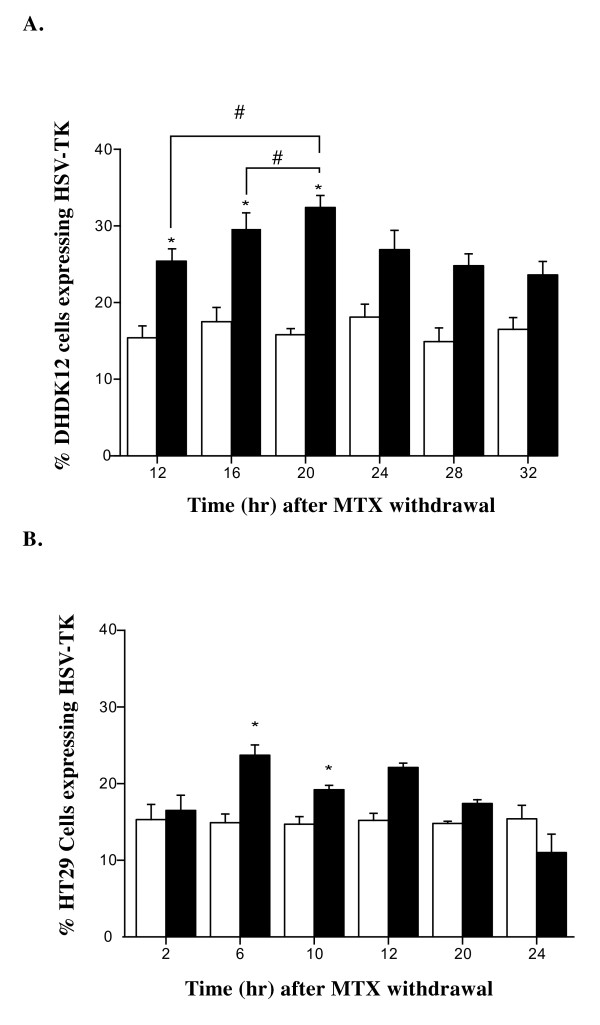
Infection efficiency of the HSV-tk retroviral vector. DHDK12 cells (A) and HT29 cells (B) were treated for 24 hr with (filled square) or without (open square) MTX. Cells were transduced with TG 9344 at the indicated times after MTX washout. The HSV-TK expression level was determined 48 hr after transduction by flow cytometry using a mouse monoclonal 4C8 antibody against HSV-TK protein. Data are expressed as the mean ± SE from at least three separate experiments. *P <.05 vs. untreated cells, # P <.05 vs. MTX-treated cells at 12 and 16 hr after MTX withdrawal.